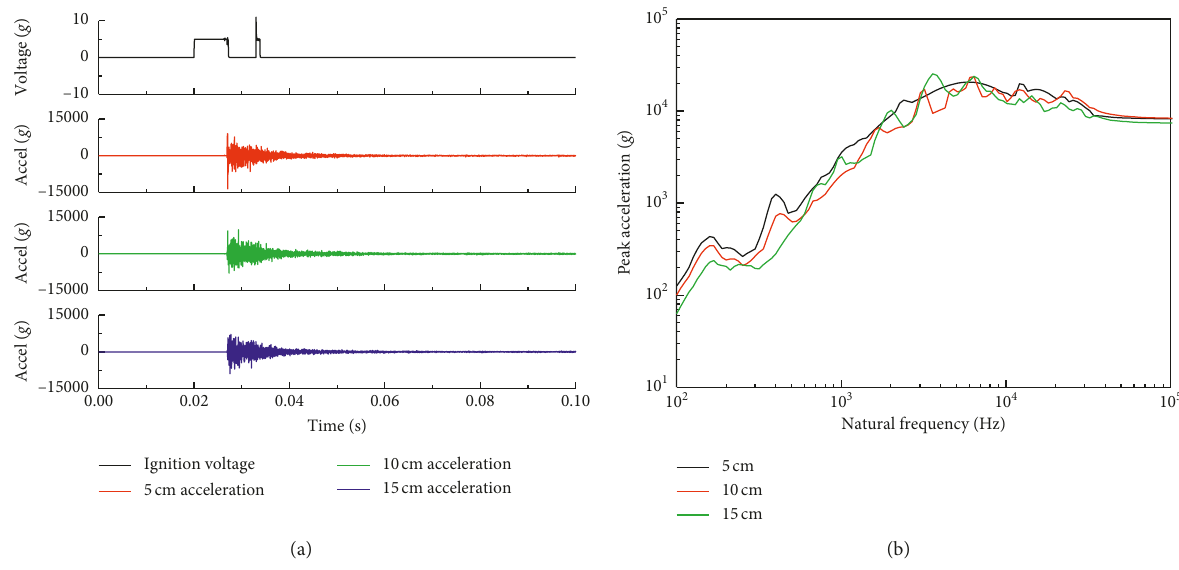
F IGURE 5: (a) Typical acceleration history and (b) shock response spectrum (SRS) from the